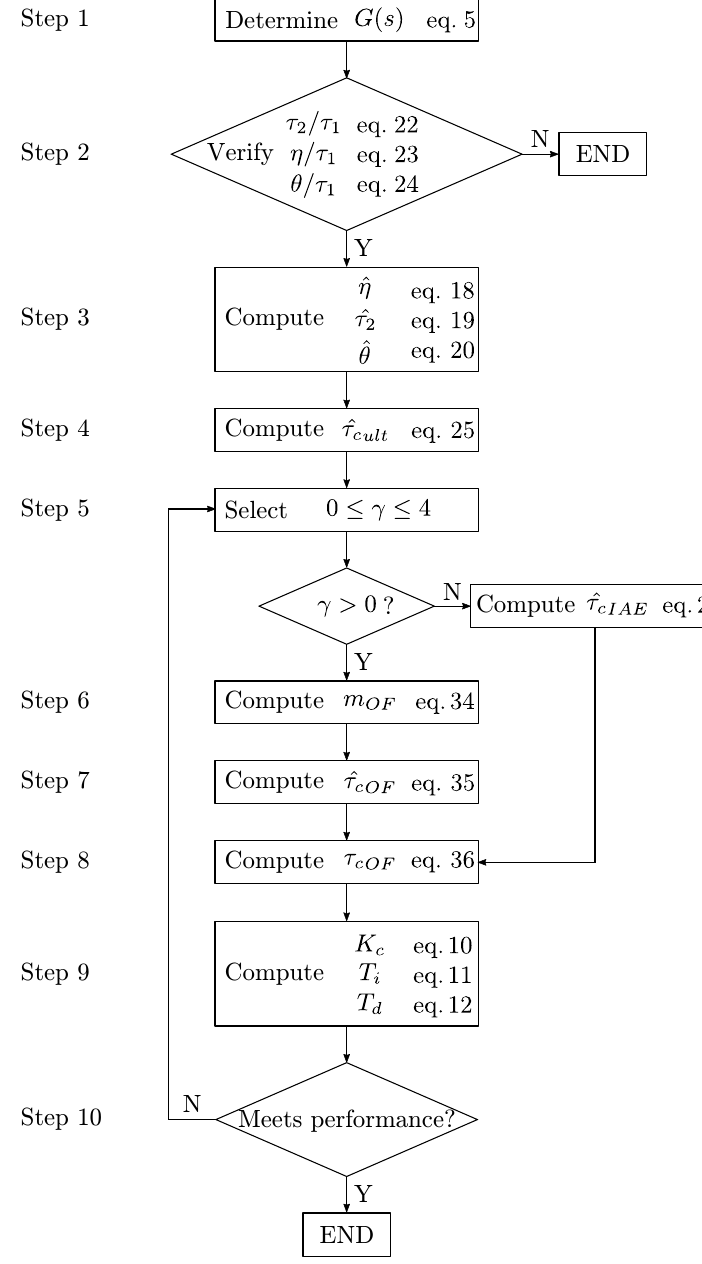
Figure 4. CCV PID tuning